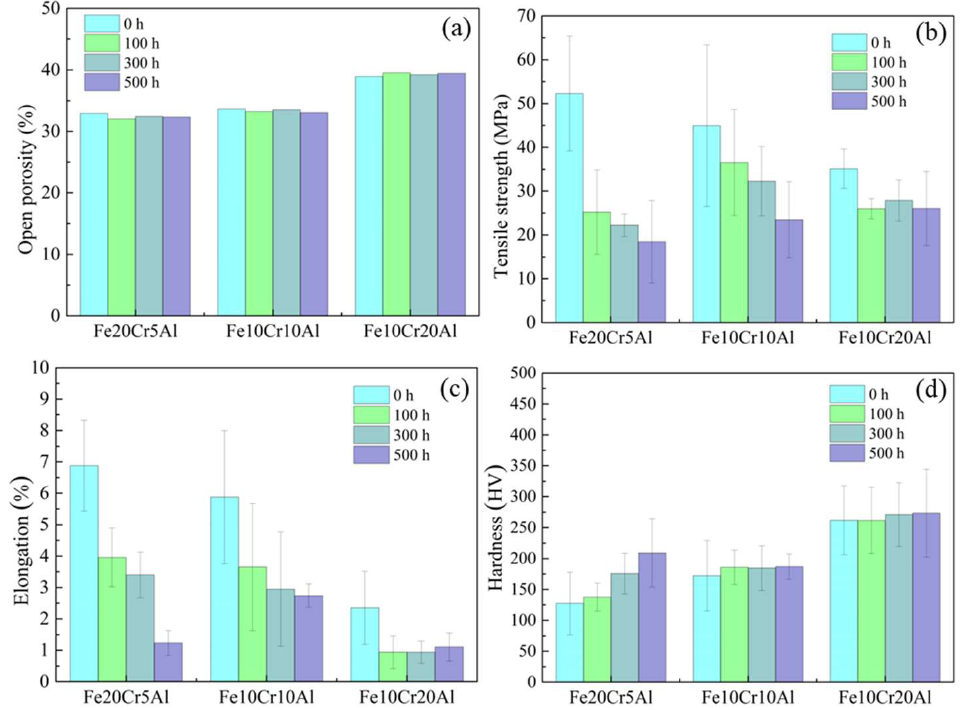
Figure 3. ( a ) Porosities, ( b ) tensile strength, ( c ) fracture elongation and ( d ) hardness of porous Fe-Cr-Al materials aged at 480 °C for different times.